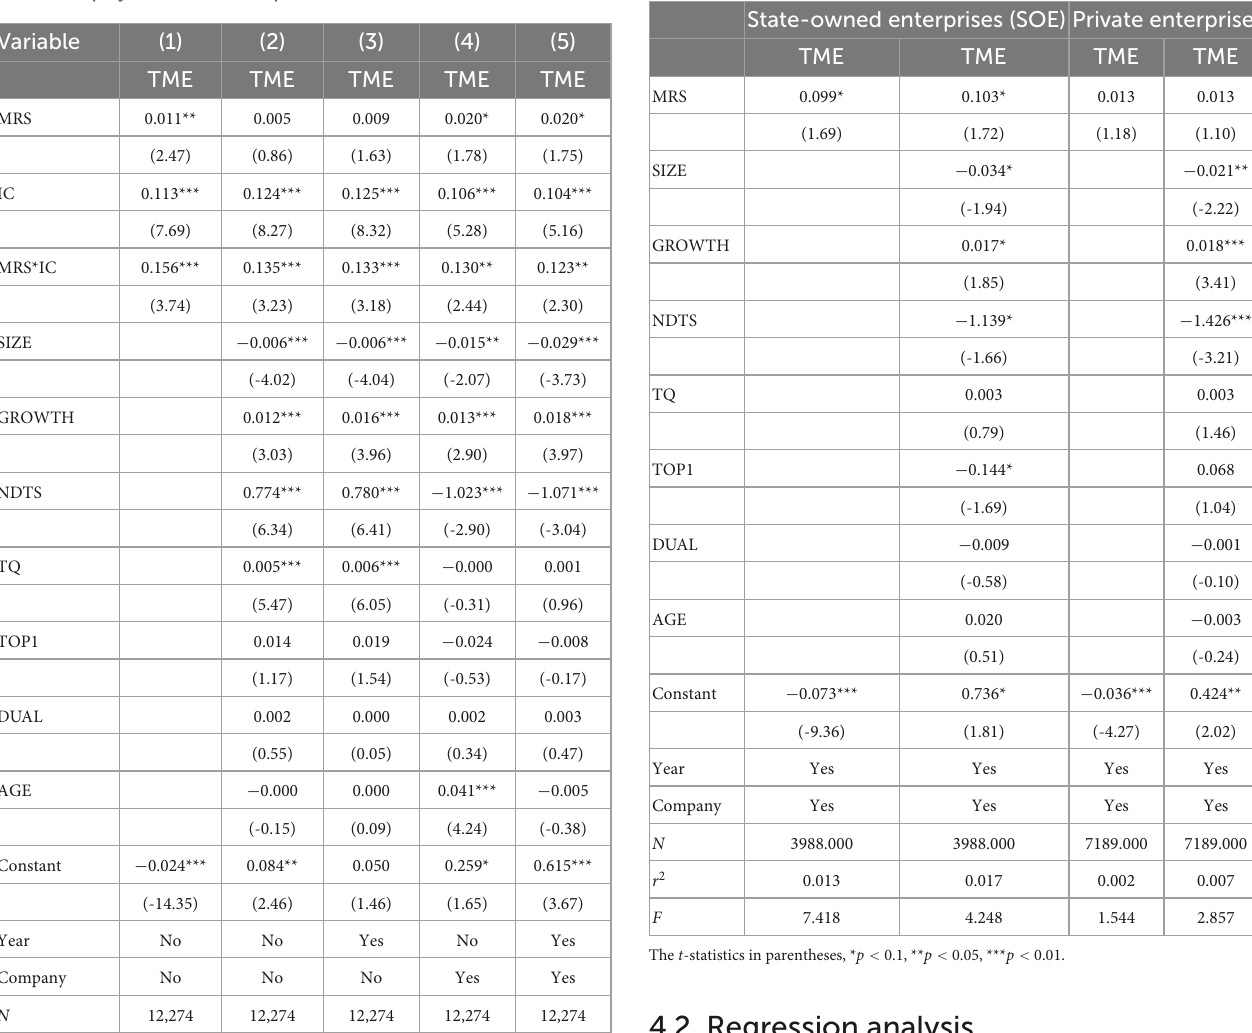
TABLE 6 Regression results of ownership nature